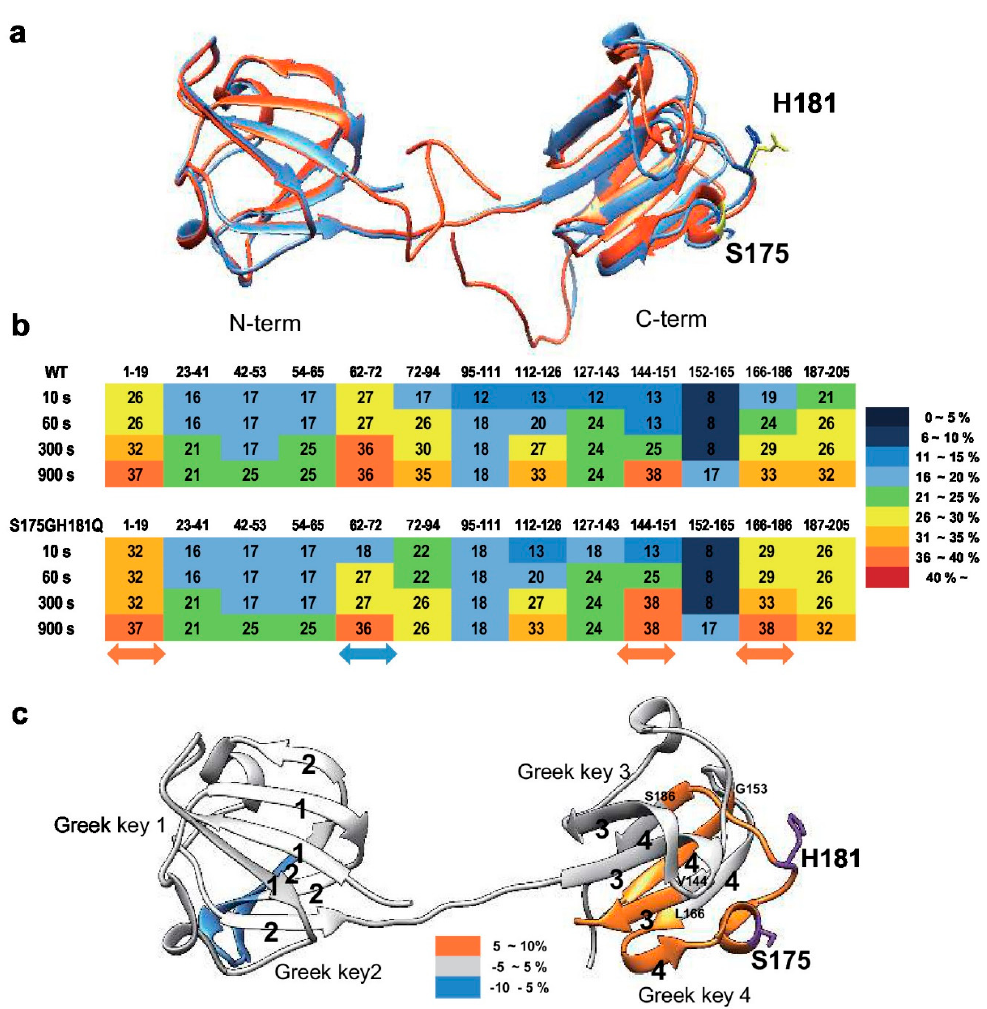
Figure 3 . Structural analysis between wild-type and S175G/H181Q mutant of β B2-crystallin. ( a ) The predicted tertiary structure of the S175G/H181Q mutant. Phyre2 structure predictions for the mutant is shown in red ribbon. WT is shown in blue ribbon (PDB ID code: 1YTQ). ( b , c ) Structural changes in WT and the mutant of β B2-crystallin analyzed by hydrogen/deuterium exchange mass spectrometry. ( b ) Deuterium exchange rate (%) of WT and S175G/H181Q mutant during incubation with D 2 O. Significantly changed representative peptides were marked by colored arrows. The corresponding deuterium exchange levels for each peptide in percent are given on the right. ( c ) Changes in hydrogen/deuterium exchange-mass spectrometry data of the mutant of β B2-crystallin compared to the WT onto the structures of human β B2-crystallin structure (PDB ID: 1YTQ). Percentage difference of deuterium incorporation in HDX-MS between WT and S175G/H181Q mutant is colored according to the key.